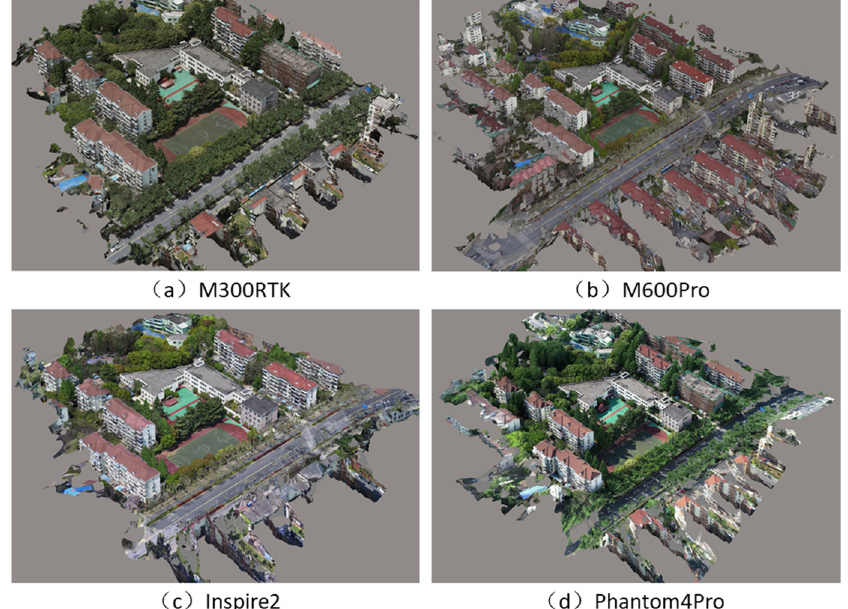
Figure 5. Three-dimensional reconstruction model of different UAVs at a height of 50 m. ( a ) Three- dimensional reconstruction model of M300RTK at a height of 50 m. ( b ) Three-dimensional reconstruction model of M600Pro at a height of 50 m. ( c ) Three-dimensional reconstruction model of Inspire2 at a height of 50 m. ( d ) Three-dimensional reconstruction model of Phantom4Pro at a height of 50 m.